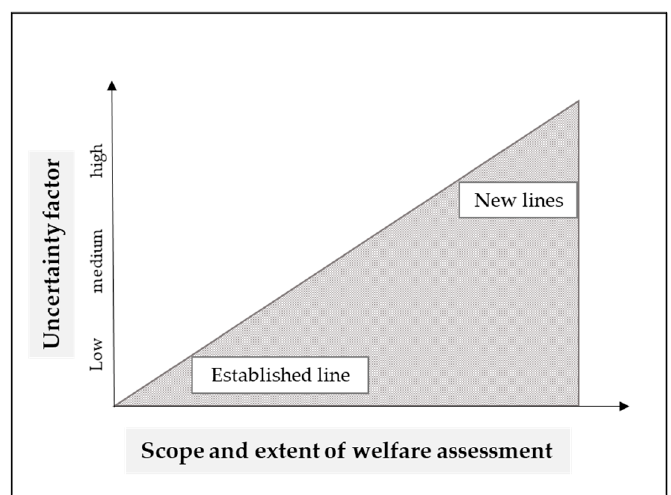
Figure 1. Correlation between uncertainty factor and welfare assessment. The scope and extent of the systematic welfare assessment and measures depend on the uncertainty factor assigned.